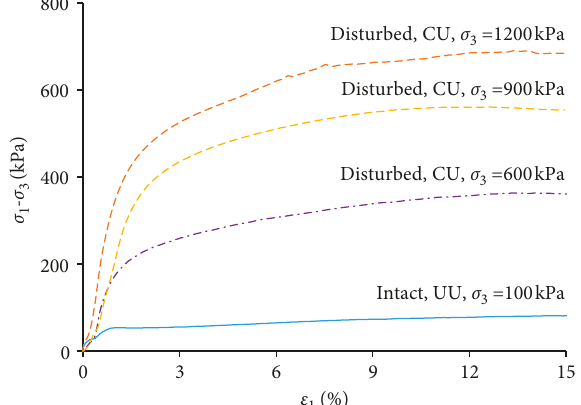
Figure 10: UU triaxial test with intact sample and CU triaxial test with disturbed